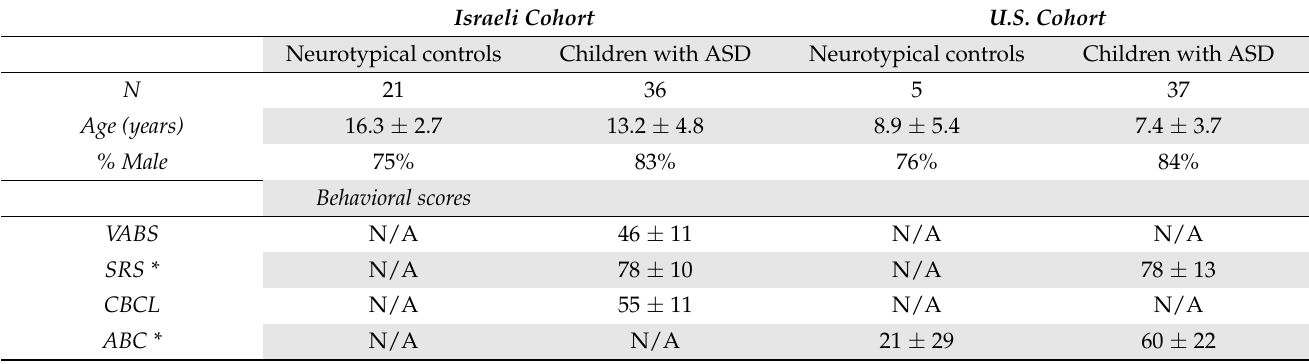
Table 1. Israeli and U.S. cohorts of whole blood samples from children with autism spectrum disorder (ASD) and neurotypical children (control). Differences in mean age between the groups within each cohort were not significant ( p > 0.1). The mean ages of the ASD and NT children were lower in the U.S. than in the Israeli cohort ( p < 0.0001 and p = 0.0056, respectively). * For the U.S. cohort, these behavioral scores were not available for a minority of the children with ASD. VABS: Vineland Adaptive Behavior Scale; SRS: Social Responsiveness Scale; CBCL: Child Behavior Checklist; ABC: Aberrant Behavior Checklist. Israeli Cohort U.S. Cohort Neurotypical controls Children with ASD Neurotypical controls Children with ASD